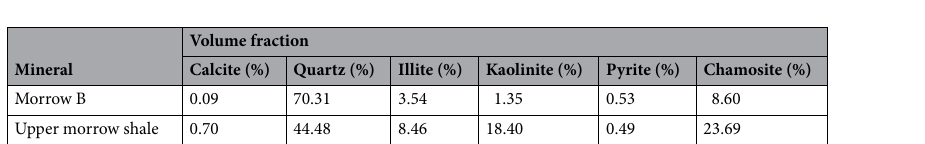
Figure 4. 2D areal view of the 13-10A inverted 5-spot pattern, showing the production wells and the injection well.